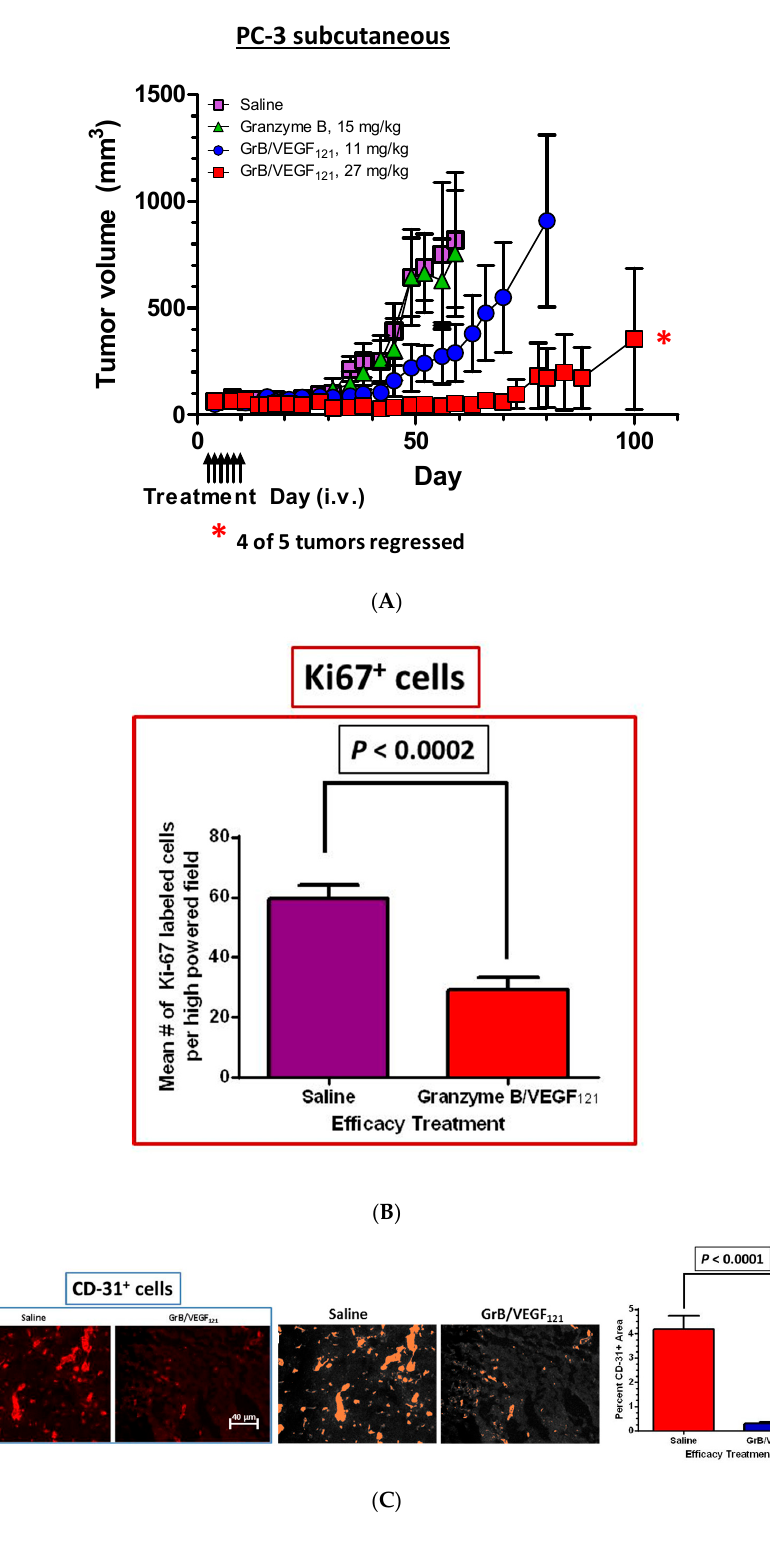
Figure 7. GrB/VEGF 121 causes regression in established tumors and a reduction in tumor proliferation. Once tumors were measurable, mice received intravenous injections of either saline, GrB (15 mg/kg) or GrB/VEGF 121 (11 or 27 mg/kg). ( A ) Treatment with GrB/VEGF 121 caused a significant reduction in the growth of the primary tumor in nude mice. i.v.: intravenous injection. ( B ) The reduction in tumor growth is partially attributed to the reduction in the proliferation rate of the tumor cells. ( C ) In addition, tumor vasculature was significantly reduced upon GrB/VEGF 121 treatment, with a greater than 14-fold reduction compared to mice treated with